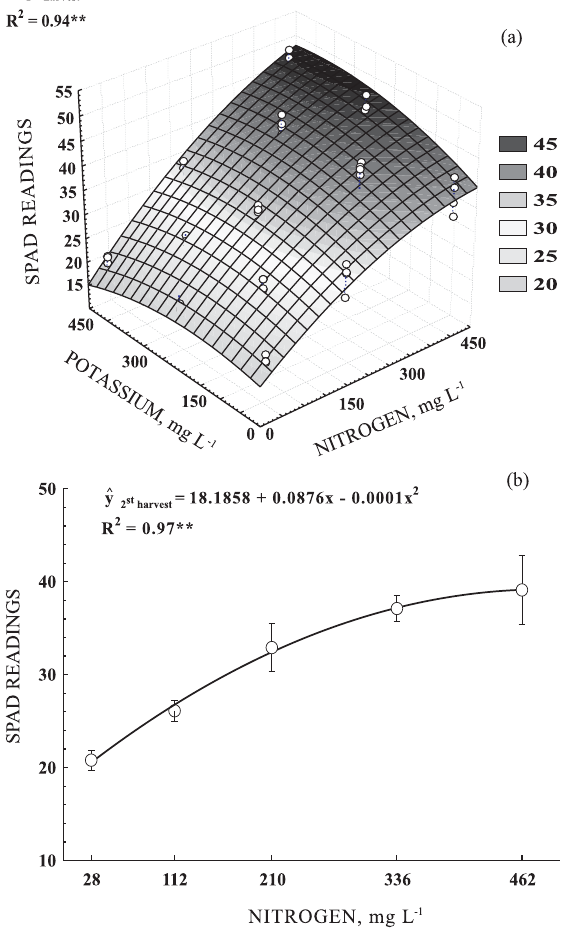
Figure 1. SPAD readings taken on the newly expanded lamina leaf (NL) of ‘Mombaça’ grass, in the first (a) and second (b) growth, as related to N and K or N